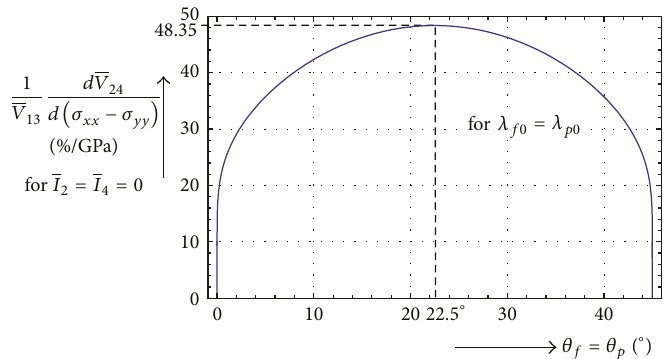
Figure 14: Sensitivity of output voltage 𝑉 24 versus mechanical stress 𝜎 𝑥𝑥 − 𝜎 𝑦𝑦 (normalized to supply voltage 𝑉 13 ) for offset-free circular devices of Figure 13. All other components of the stress tensor vanish, as well as 𝜎 𝑥𝑥 + 𝜎 𝑦𝑦 = 0 . The plot is a graphical representation of (26b), (28b), (28c), (18a)–(18i), and (19b) in the limit of small stress and with the piezoresistive coefficient 𝜋 44 = 1.381/ GPa for low p-doped silicon. Largest stress sensitivity of 48.3501%/GPa is obtained for aspect ratios 𝜃 𝑓 = 𝜃 𝑝 = 22.5 ∘ which means 𝜆 𝑓0 = 𝜆 𝑝0 = √2 and this is also the number of squares between supplies or sense contacts. The curve is mirror symmetric to 𝜃 𝑓 = 𝜃 𝑝 = 22.5 ∘ .